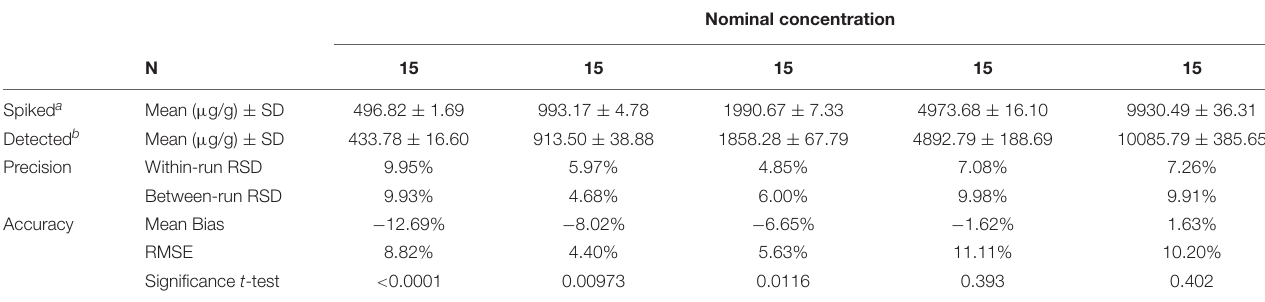
TABLE 2 | Precision and accuracy summary table of the method for the quantitative detection of histamine in the enriched broth cultures.